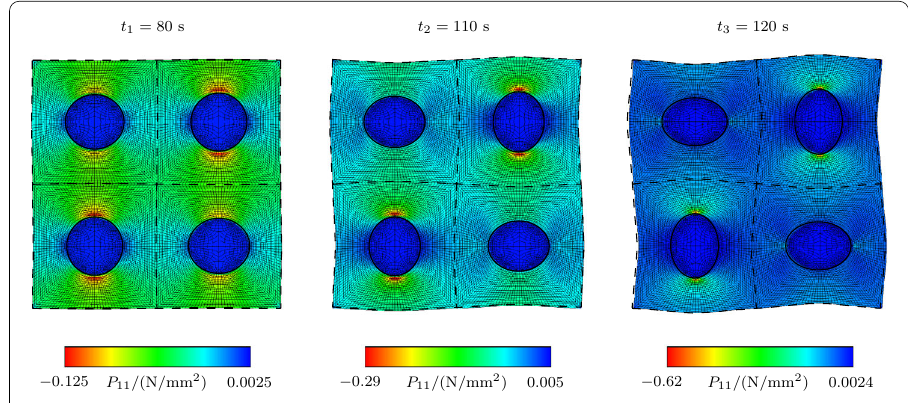
Fig. 12 Pattern transformation due to macroscopically driven swelling of a periodic RVE. Due to swelling of the matrix, the microscopic inclusions initially shrink homogeneously. Then, at a critical loading point, the periodic RVE undergoes a pattern transformation such that the initially circular inclusions deform to non-circular shapes. The contour shows the P 11 component of the first Piola-Kirchhoff stress tensor P at